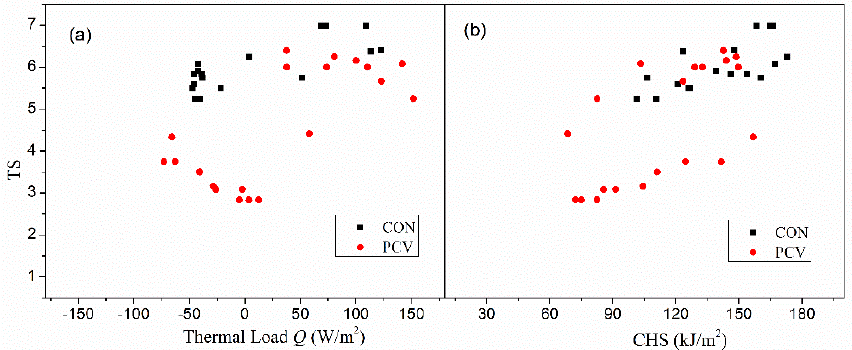
Figure 5. Relationships of thermal sensation with ( a ) Q , and ( b ) CHS.